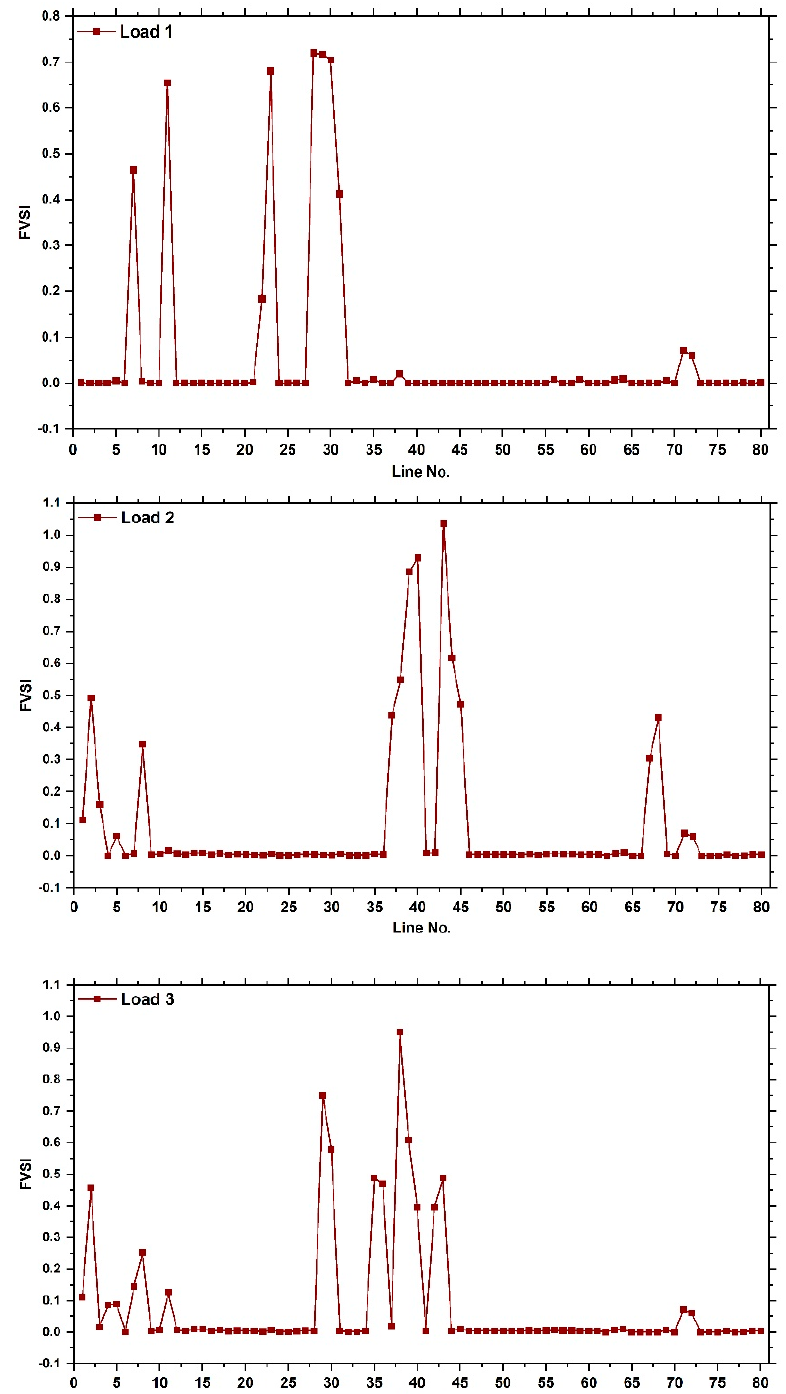
Figure 8. Fast voltage stability index point (FVSI) of Load 1, Load 2 and Load